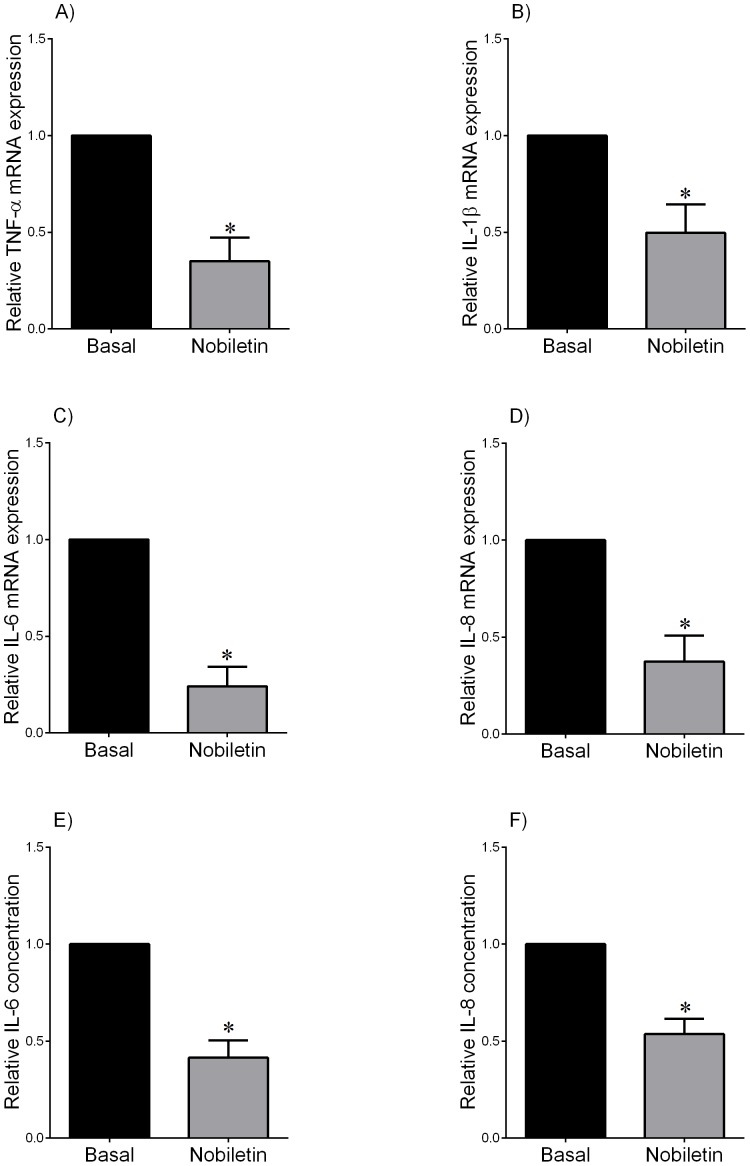
Effect of nobiletin on pro-inflammatory cytokines in preterm fetal membranes.Preterm fetal membranes with histological chorioamnionitis and following spontaneous preterm labour were incubated for 20 h with or without 200 µM nobiletin (n = 9 patients). (A–D) TNF-α, IL-1β, IL-6 and IL-8 mRNA expression was analysed by qRT-PCR and normalised to GAPDH mRNA expression. The fold change was calculated relative to basal expression, which was set at 1. Data is displayed as mean ± SEM (one-way ANOVA). *P<0.05 vs. basal expression. (E, F) The incubation medium was assayed for concentration of IL-6 and IL-8 by ELISA. Data was normalised to untreated (basal) levels, which was set at 1. Each bar represents mean ± SEM (one-way ANOVA). *P<0.05 vs. basal release.